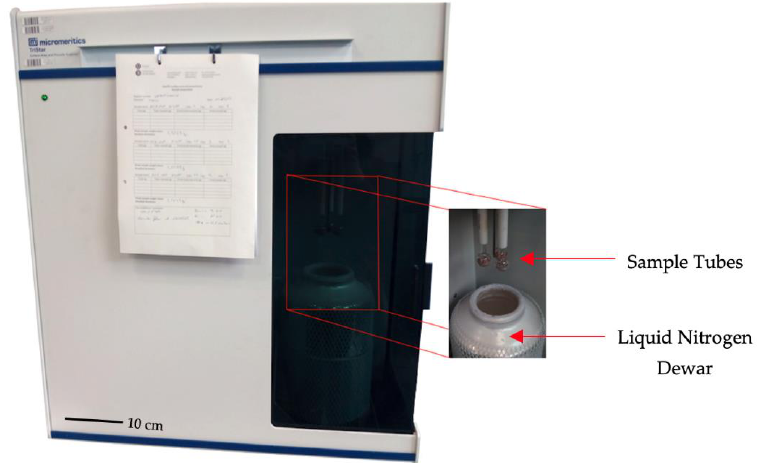
Figure 2. Gas adsorption test